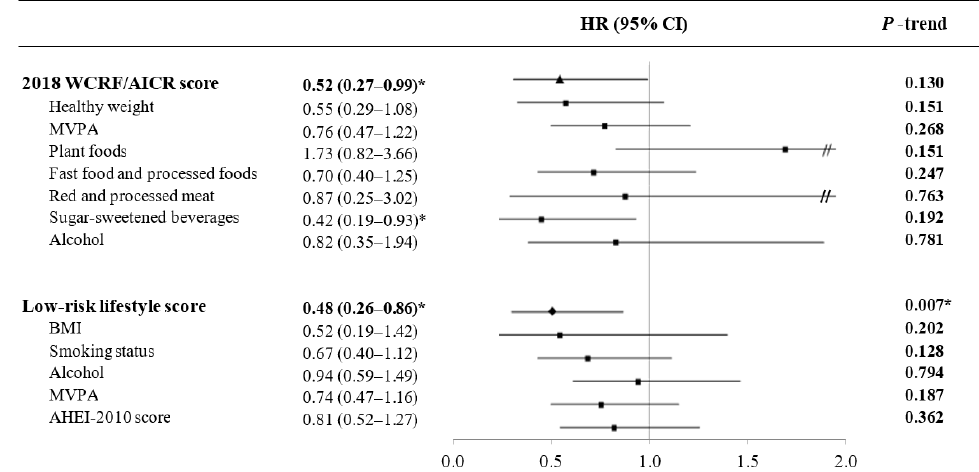
Figure 1. Colorectal cancer risk associated with 2018 WCRF/AICR and low-risk lifestyle scores and the individual components of each index in the PREvención con DIeta MEDiterránea (PREDIMED) cohort ( n = 7216). Multivariable Cox proportional regression models were used. Results were the HRs (95% CIs) for the comparison between the highest vs. the lowest quantile for each overall score (2018 WCRF/AICR score: Quartile (Q) 4 vs. Q1; low-risk lifestyle score: Tertile (T) 3 vs. T1) and the comparison for the highest vs. the lowest category for each individual component of the score (see Tables 3 and 4). * p -value <0.05. p for trend stands for linear trend. Abbreviations: AHEI, alternate